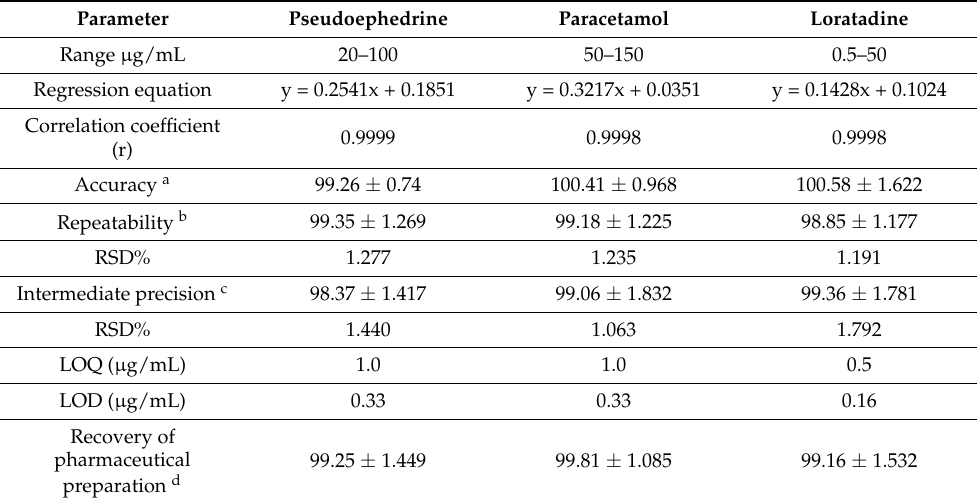
Table 3. Validation parameters and assay of pharmaceutical formulation using the proposed